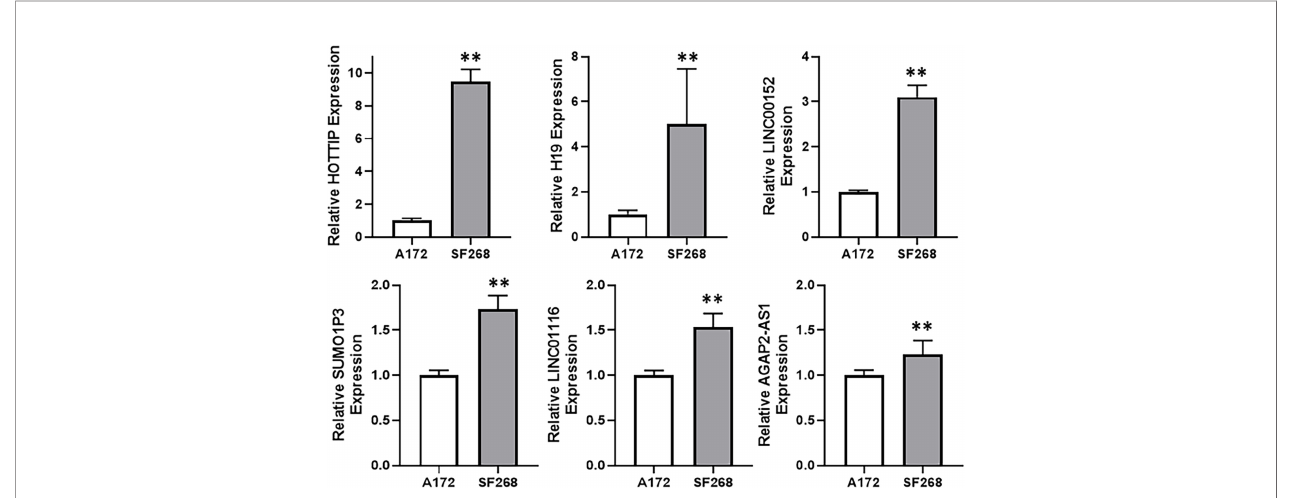
FIGURE 2 | HOTTIP is elevated in TMZ resistant cells. Expression levels of different lncRNAs were evaluated in A172 vs. SF268 cells, by RT-PCR. The values in A172 cells were regarded as ‘ 1 ’ and relative values in SF268 cells are reported. **p <